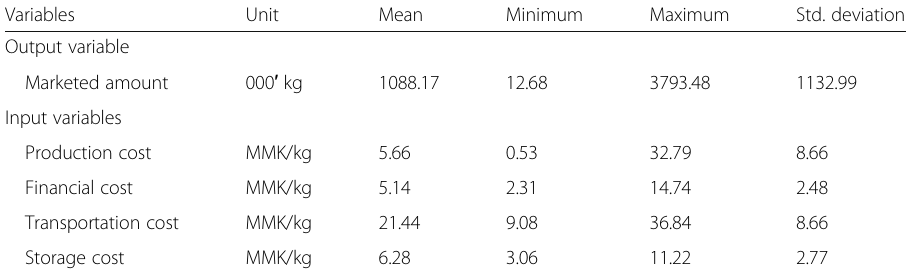
Table 7 Descriptive statistics of the output and input variables of the rice millers ( N = 25) Variables Unit Mean Minimum Maximum Std. deviation Output variable Marketed amount 000 ′ kg 1088.17